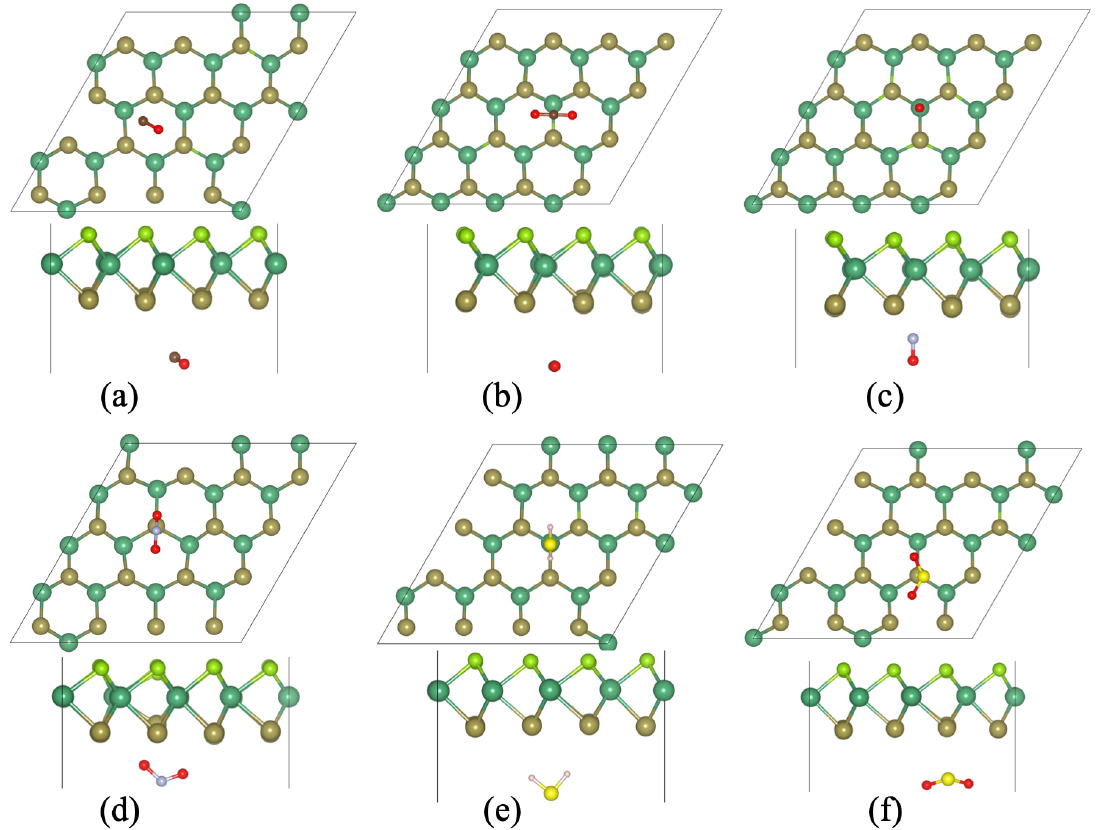
Figure 3. Optimized structure of toxic gas molecules adsorbed on the surface of the Janus NbSeTe monolayer with the top and side view. ( a ) CO, ( b ) CO 2 , ( c ) NO, ( d ) NO 2 , ( e ) H 2 S, and ( f ) SO 2 gas molecules adsorbed on the Te-side of the Janus NbSeTe